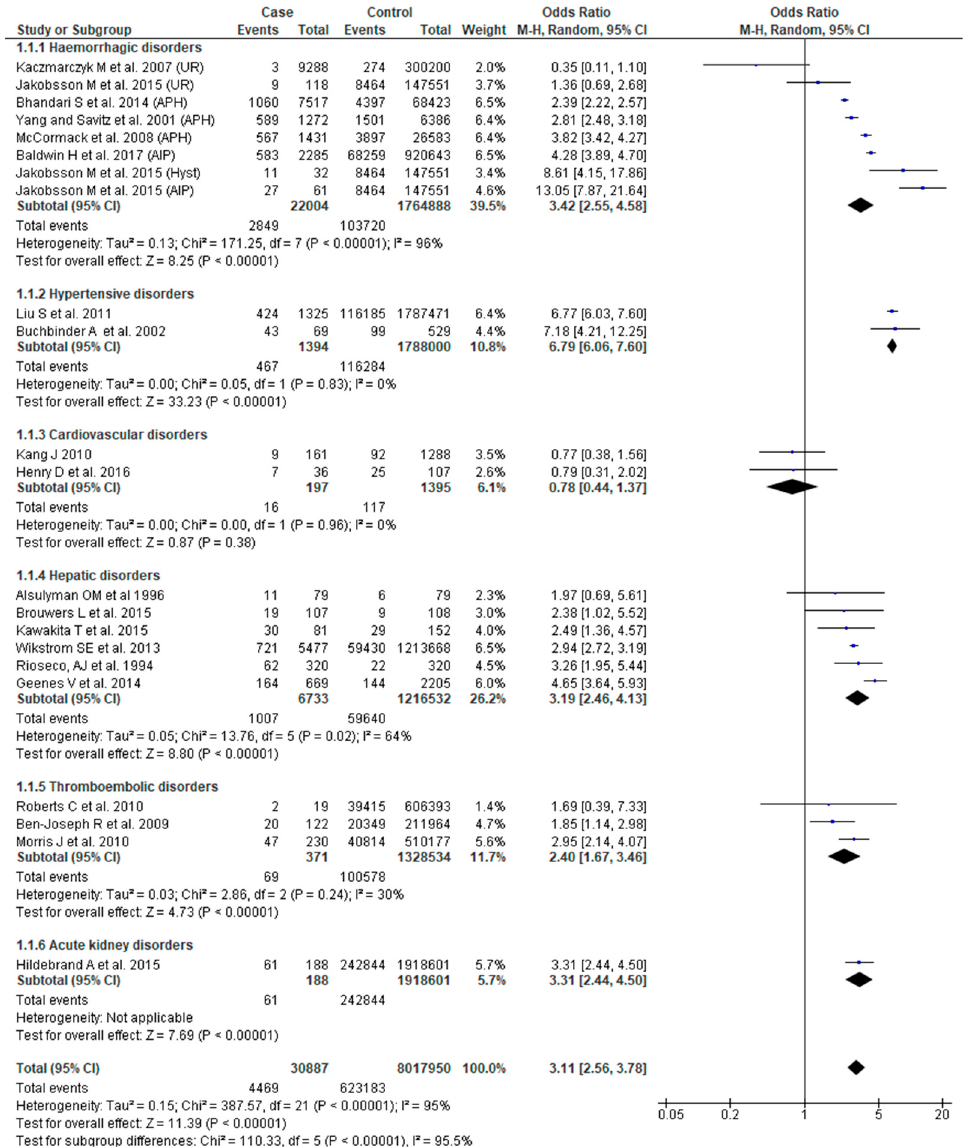
Figure 2. Forest plot of studies assessing association of Severe maternal morbidity (SMM) and preterm birth.